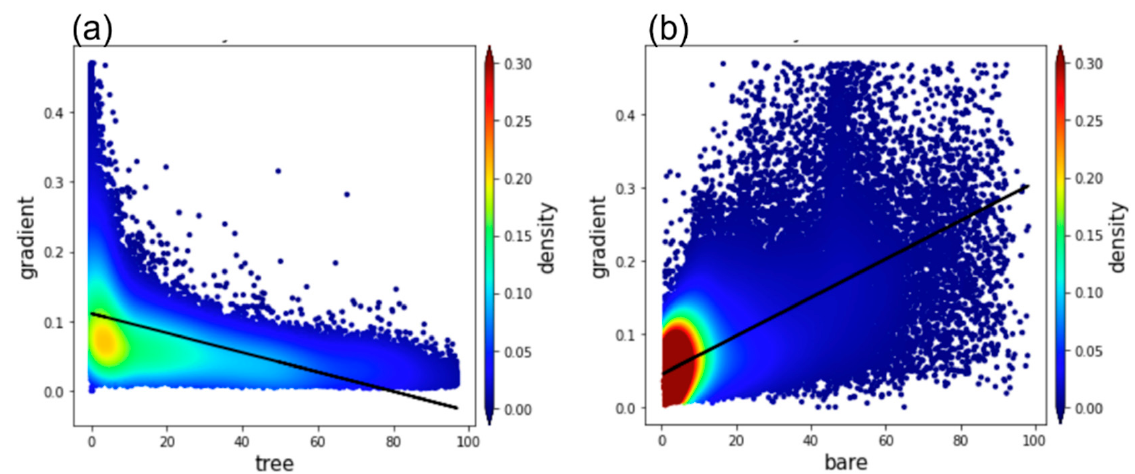
Figure 4. Relationship between yearly b/y [-] (see Section 2) and VCF vegetation coverage [%] of ( a ) tree canopy and ( b ) bare soil in 2012. Contours show the density of pixels. Black lines show the linear regression.